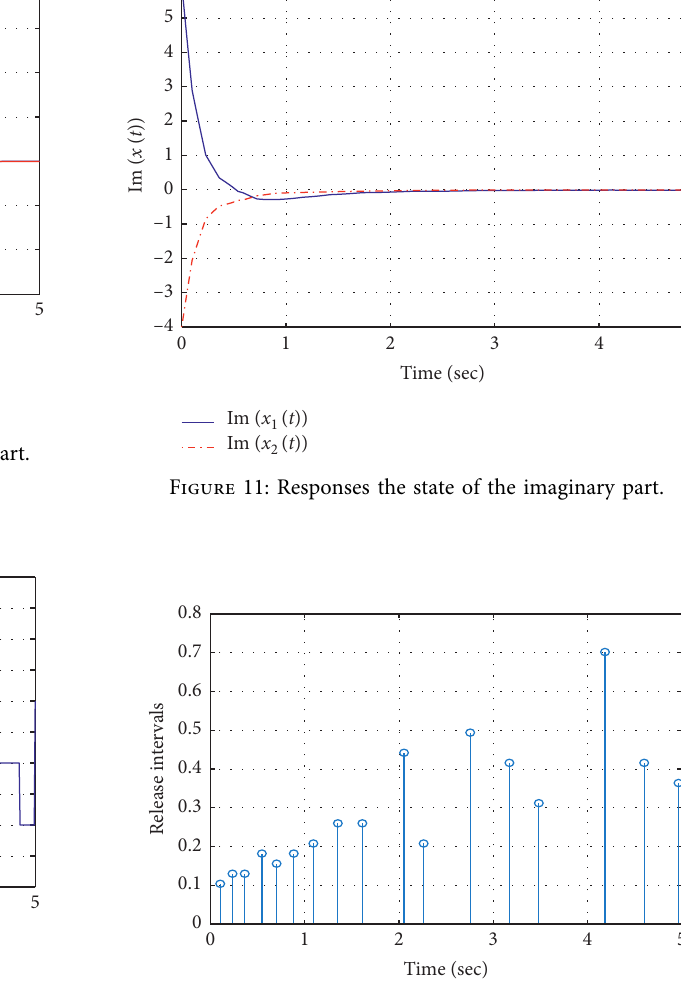
Figure 12: The interval of the event-triggered.